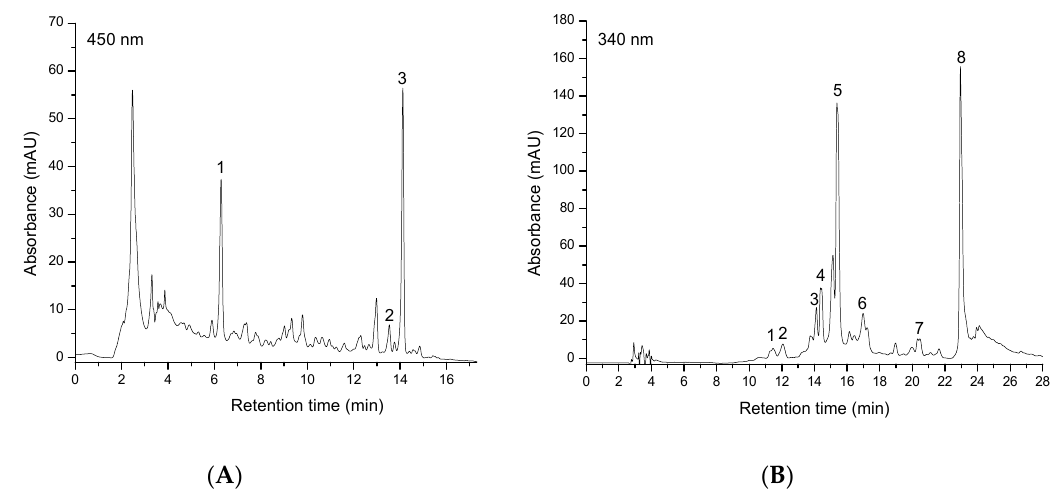
Figure 2. HPLC chromatograms of ethanolic tomato by-products extract for carotenoids ( A ) and for phenolic compounds ( B ). Table 1. Identification of carotenoids and phenolic compounds in tomato processing by-products extract (TBE).